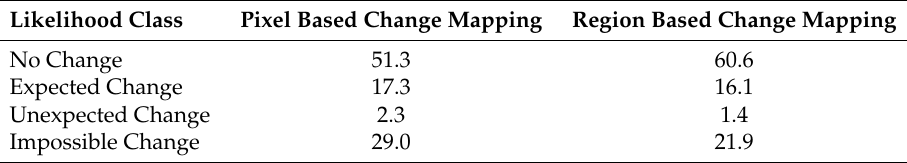
Table 6. The occurrence (%) of each likelihood class in final change mappings obtained using L1 legend, calculated over the mode of change